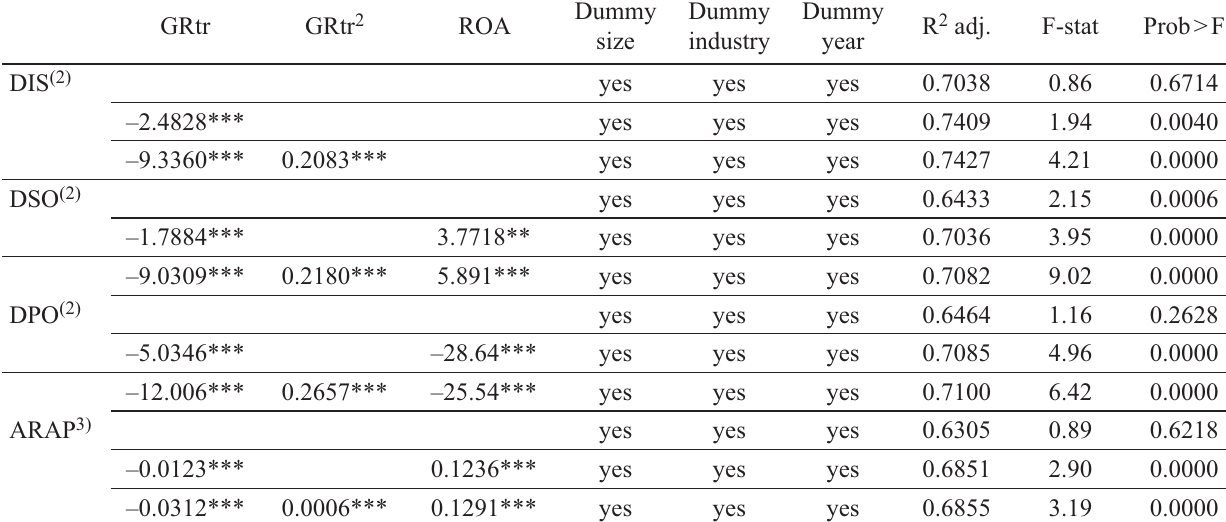
Table 4. Fixed effects models for the dependence of current assets on the growth rate and control variables